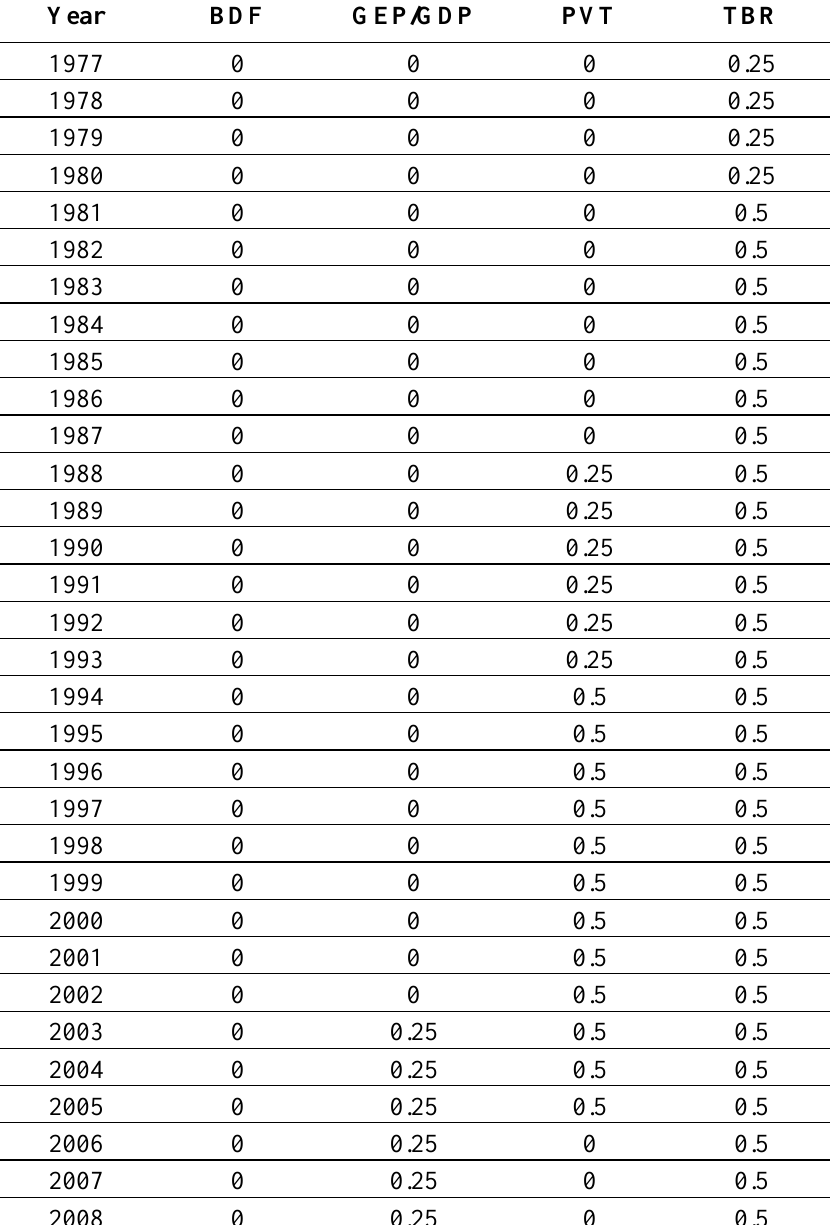
Table 2: Liberalization of the Real Sector – Scores Assigned